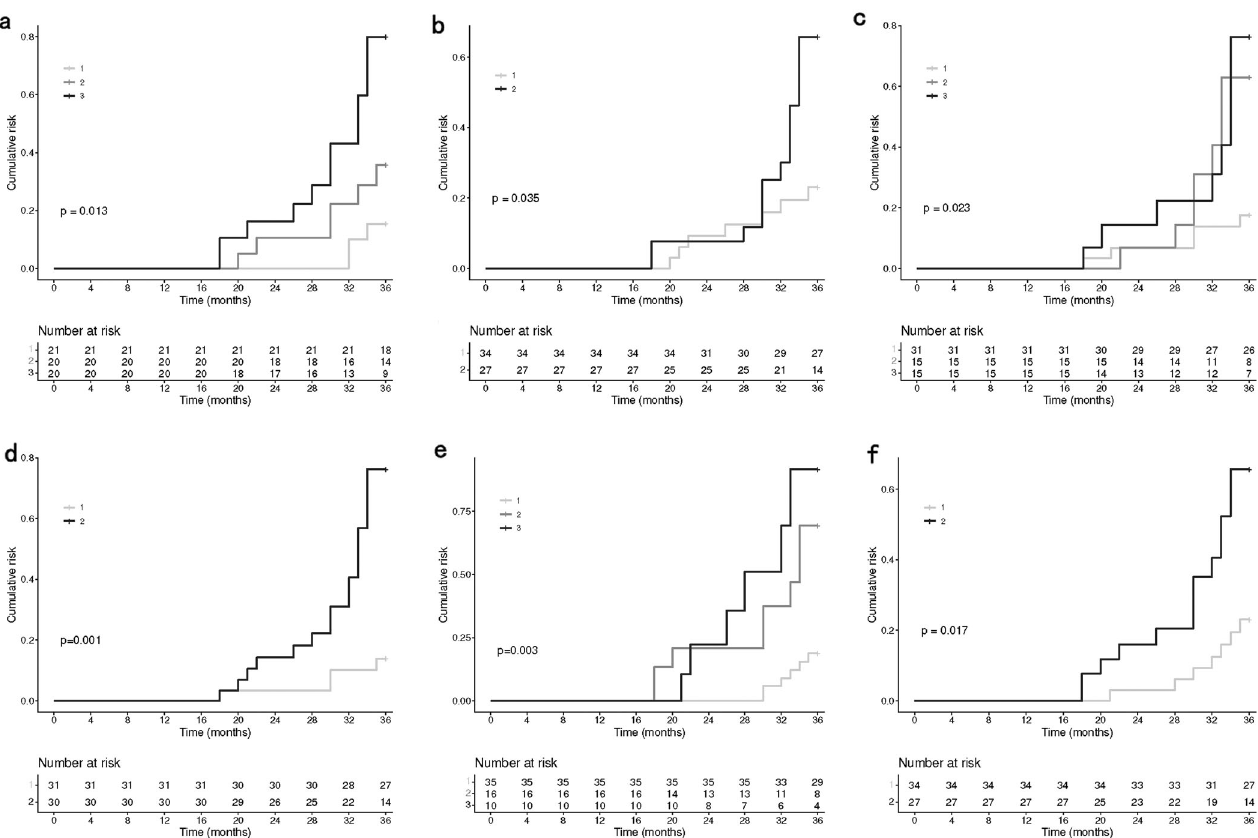
Fig. 3 Kaplan – Meier estimates showing the effects on dyskinesia of some clinical characteristics. a NMSS ( “ 1 ” represents the fi rst tertile, “ 2 ” represents the second tertile, and “ 3 ” represents the third tertile), b HAMA ( “ 1 ” represents <7, and “ 2 ” represents ≥ 7), c LEDD ( “ 1 ” represents ≤ 400 mg, “ 2 ” represents 400~600 mg, and “ 3 ” represents >600 mg), d LEDD/Weight ( “ 1 ” represents ≤ median, and “ 2 ” represents >median), e duration of PD ( “ 1 ” represents ≤ 5 y, “ 2 ” represents 5~10 y, and “ 3 ” represents > 10 y), f PSQI ( “ 1 ” represents <6, and “ 2 ” represents ≥ 6). NMSS Non-Motor Symptom Scale, HAMA Hamilton Anxiety Rating Scale, LEDD Levodopa equivalent daily dose, PSQI Pittsburgh Sleep Quality